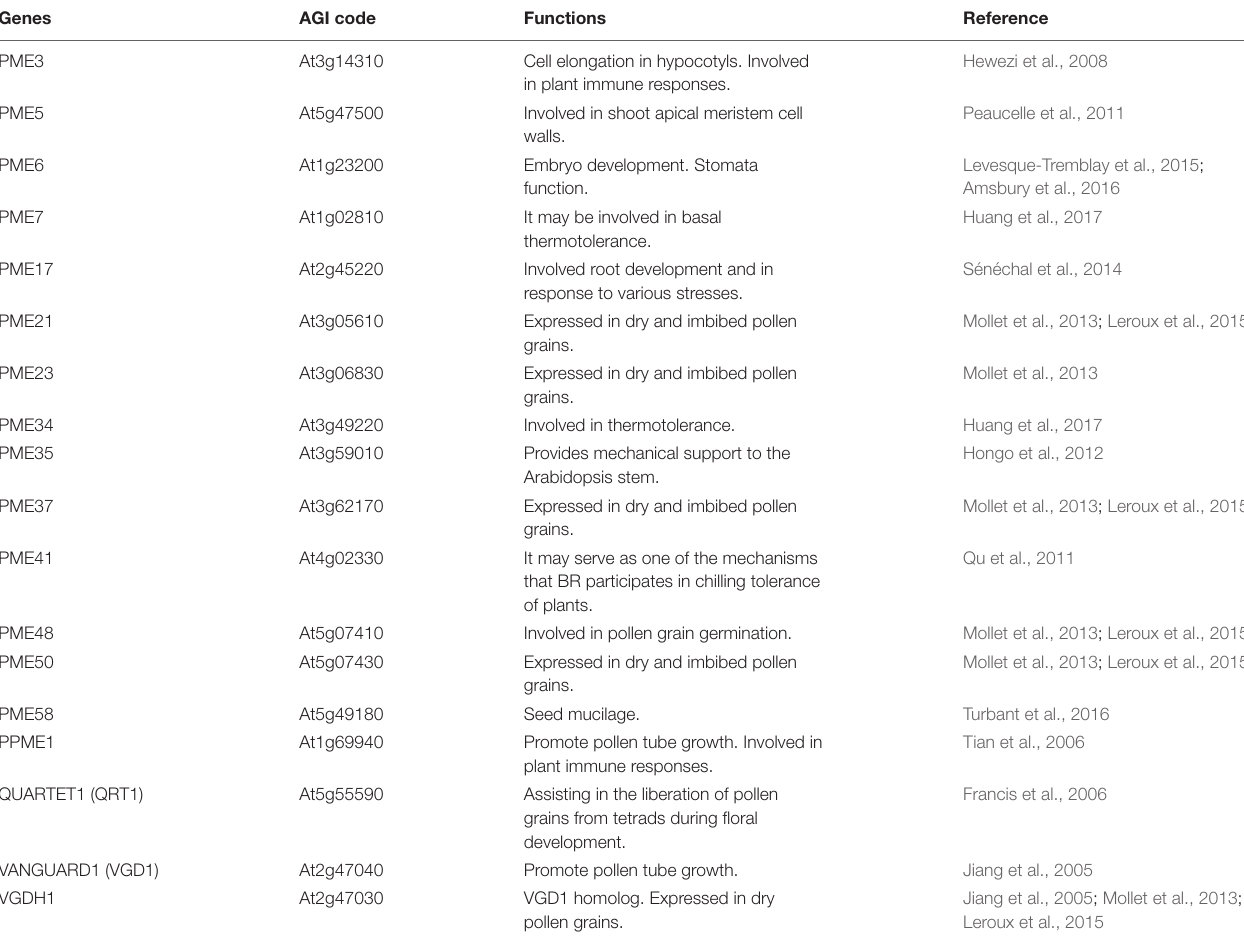
TABLE 1 | Identification of specific Pectin methylesterase ( PME ) genes reveals multiple roles of PME in Arabidopsis. Genes AGI code